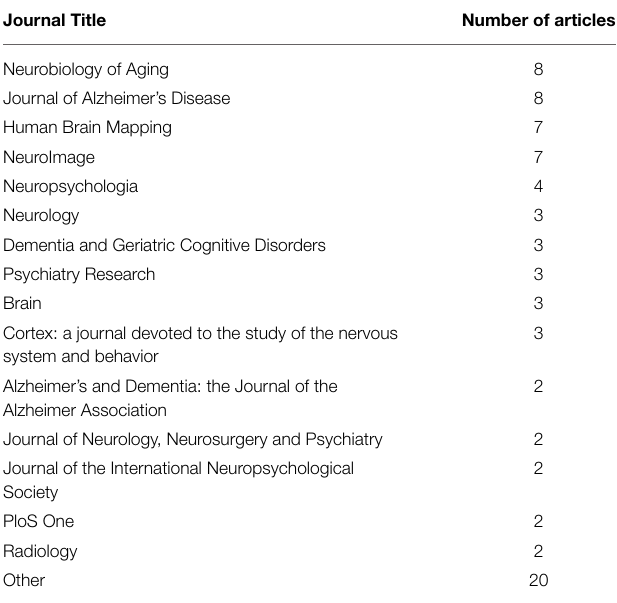
TABLE 2 | Summary of Journals in the